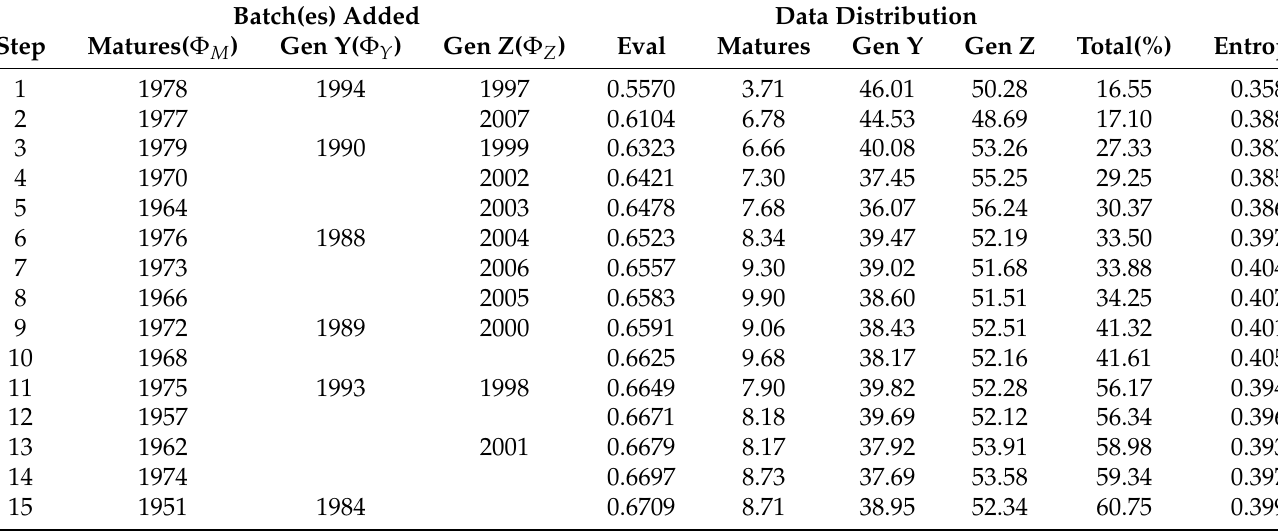
Table 5. Curriculum discovered by AGCL. Results are shown in terms of macro-F1-score on the evaluation set (Eval). This table also highlights the percentage of the data (from the 394,745 training instances) used for building each model (Total). It additionally displays its respective class distribution (%) and